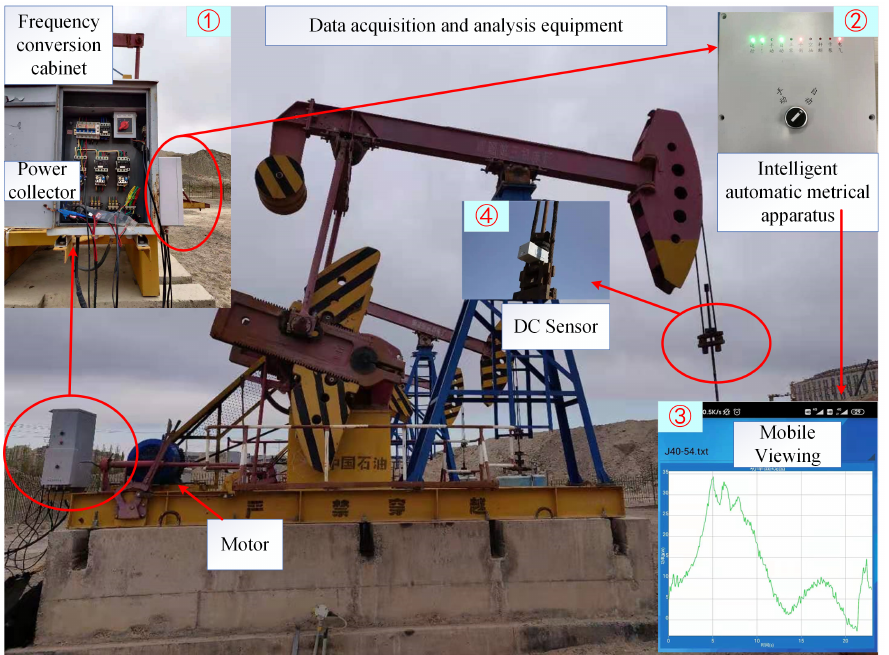
Figure 5. Self-developed data acquisition and analysis equipment employed in the SRPS.